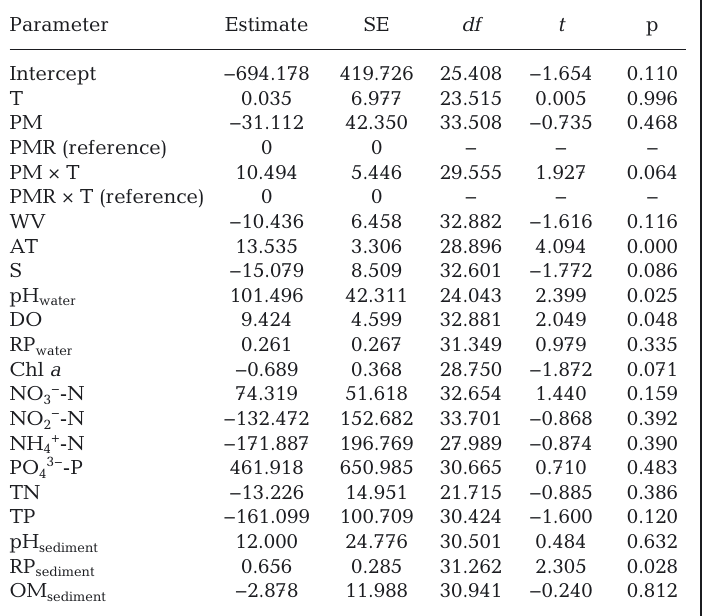
Table A1. Estimates of the fixed effects. T: sampling time; PM: polyculture system of swimming crab with kuruma shrimp; PMR: polyculture system of swimming crab with kuruma shrimp and short-necked clam; WV: wind ve- locity; AT: air temperature; S: salinity; pH water : water pH; DO: